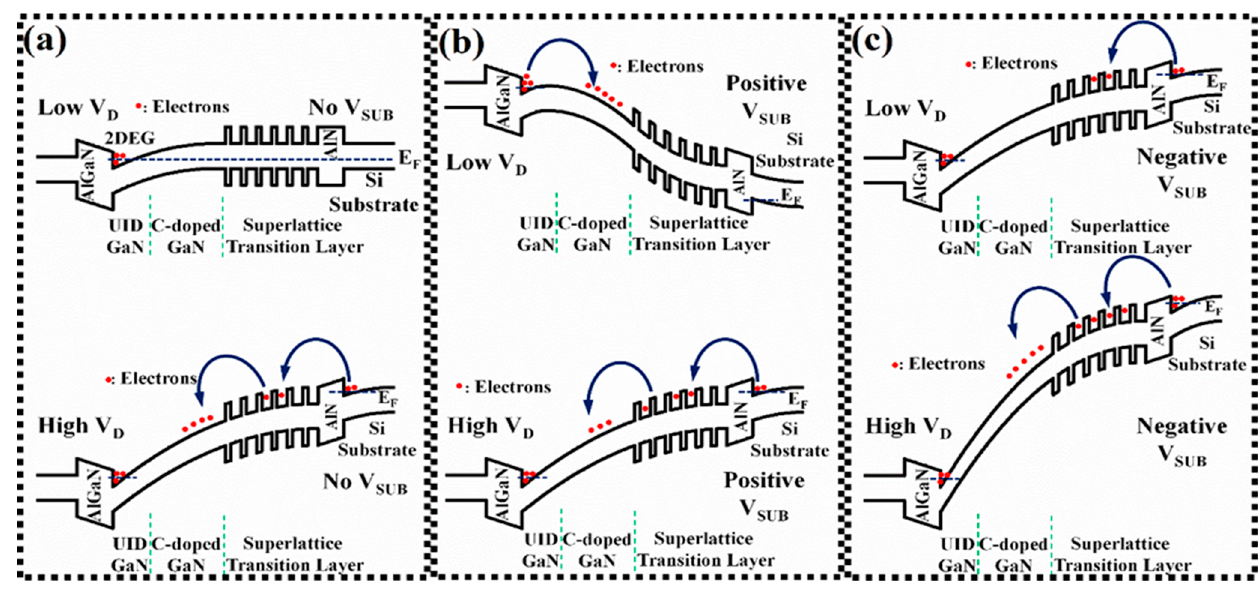
Figure 3. Band diagram with different V SUB and low/high V D condition. ( a ) Without V SUB , ( b ) with positive V SUB , ( c ) with negative V SUB . positive V SUB , ( c ) with negative V SUB